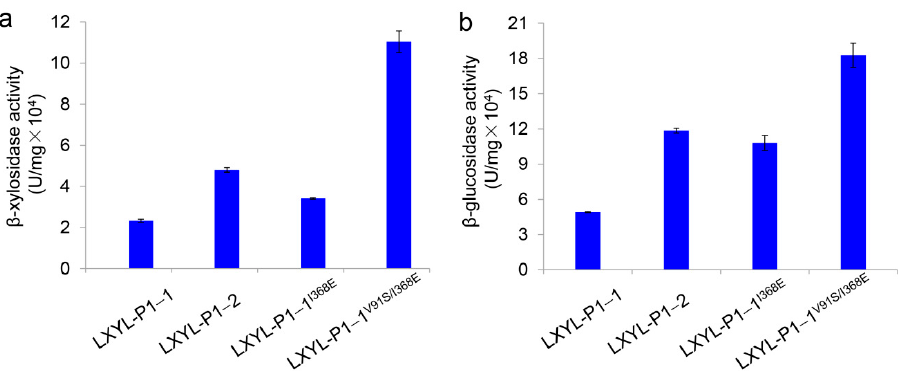
Figure 2. Comparison of β -xylosidase ( a ) and β -glucosidase ( b ) activities between the purified mutants. Data are mean ± SD. n = 3.